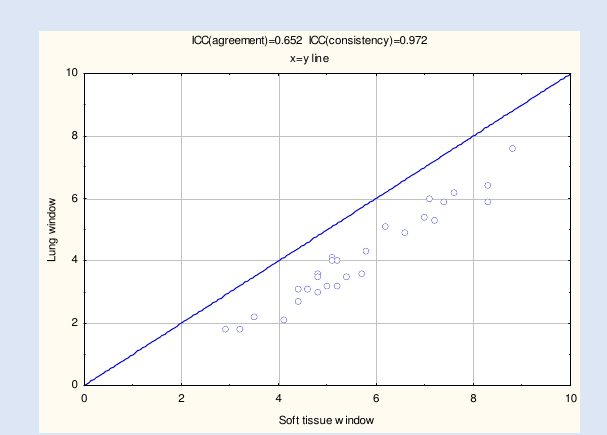
Graph 5. Comparison between measurements in soft tissue and lung windows in the trachea 